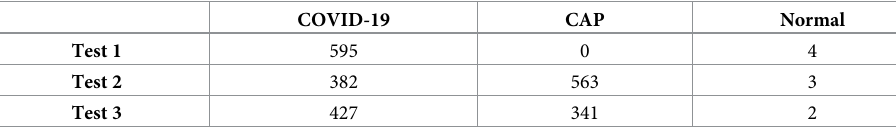
Table 8. The number of slices extracted from each test set to augment the train